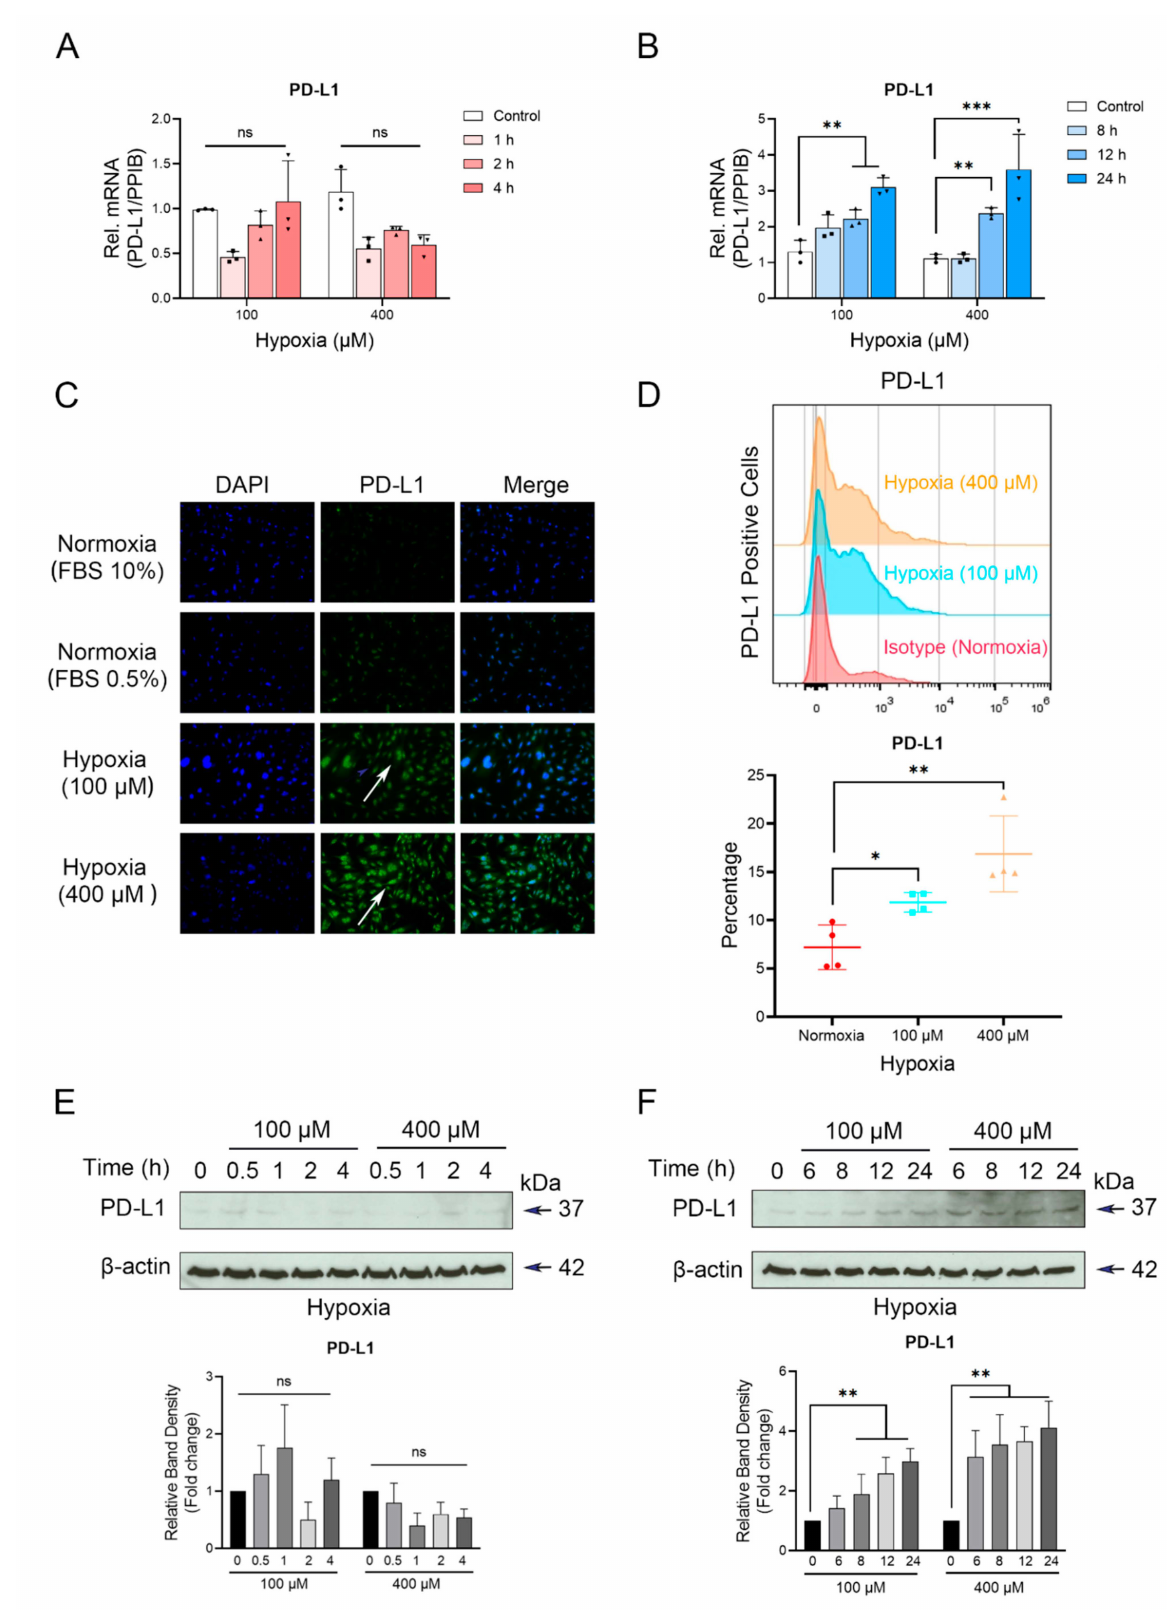
Figure 1. CoCl 2 -mimicked hypoxia selectively up-regulates PD-L1 expression on OCCM-30 cells. OCCM- 30 cells were cultured under CoCl 2 -induced hypoxia (100 µ M or 420 µ M) for the indicated time